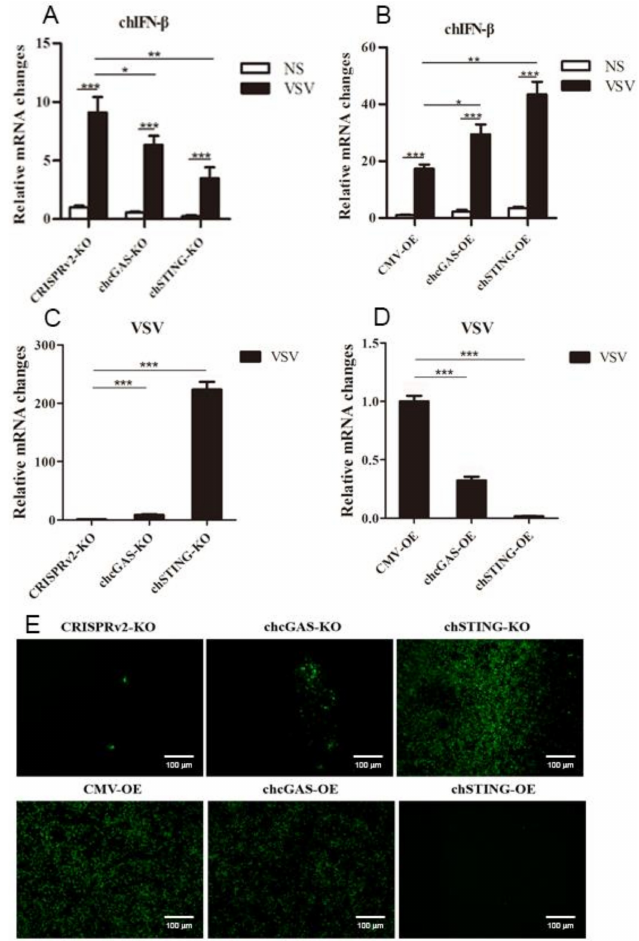
Figure 7. VSV-GFP replications in chGAS and chSTING stable HD11 cells. HD11 KO and OE stable cells in 12-well plate (2 × 10 5 cells / well) were infected with VSV-GFP (0.01 MOI) for 14 h and 18 h, respectively. The cells were analyzed by RT-qPCR for both cellular gene transcriptions ( A,B ) and viral gene transcriptions ( C,D ). The viral replications in HD KO and OE cells were also monitored by GFP fluorescence microscopy ( E ). The signs “*”, “**”, “***” denote p < 0.05, p < 0.01 and p < 0.001,